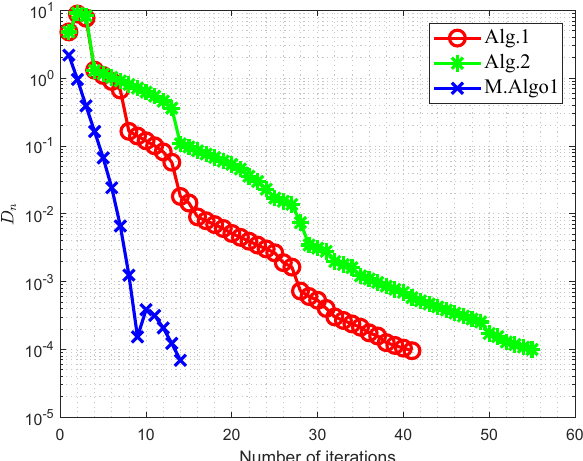
Figure 1: Numerical comparison of Algorithm 1 with Algorithm 1 in [ 30 ] and Algorithm 2 in [ 30 ] taking = N 5